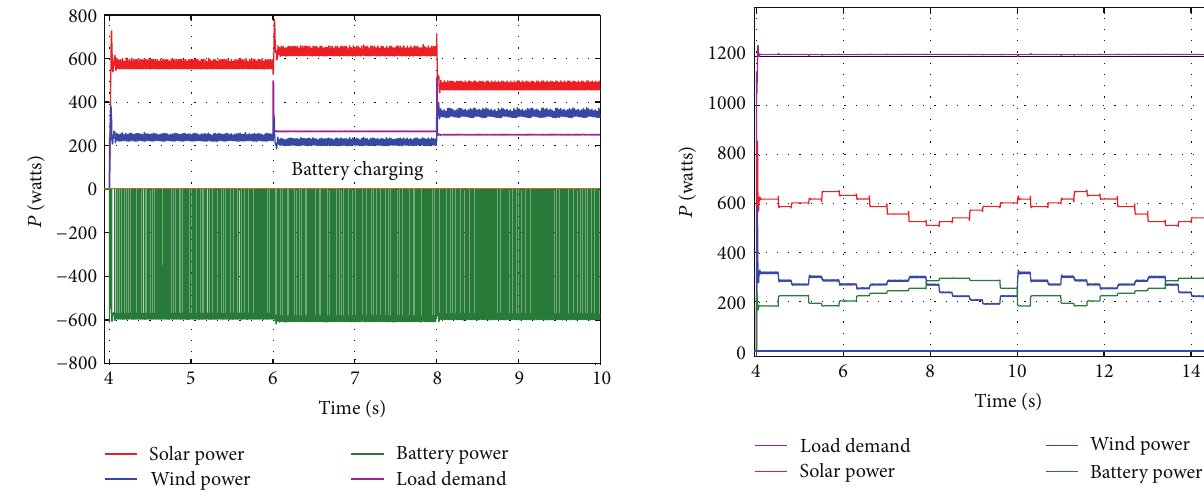
Figure 21: Solar PV panel and WTG supply load, and battery charges with surplus power at PCC.